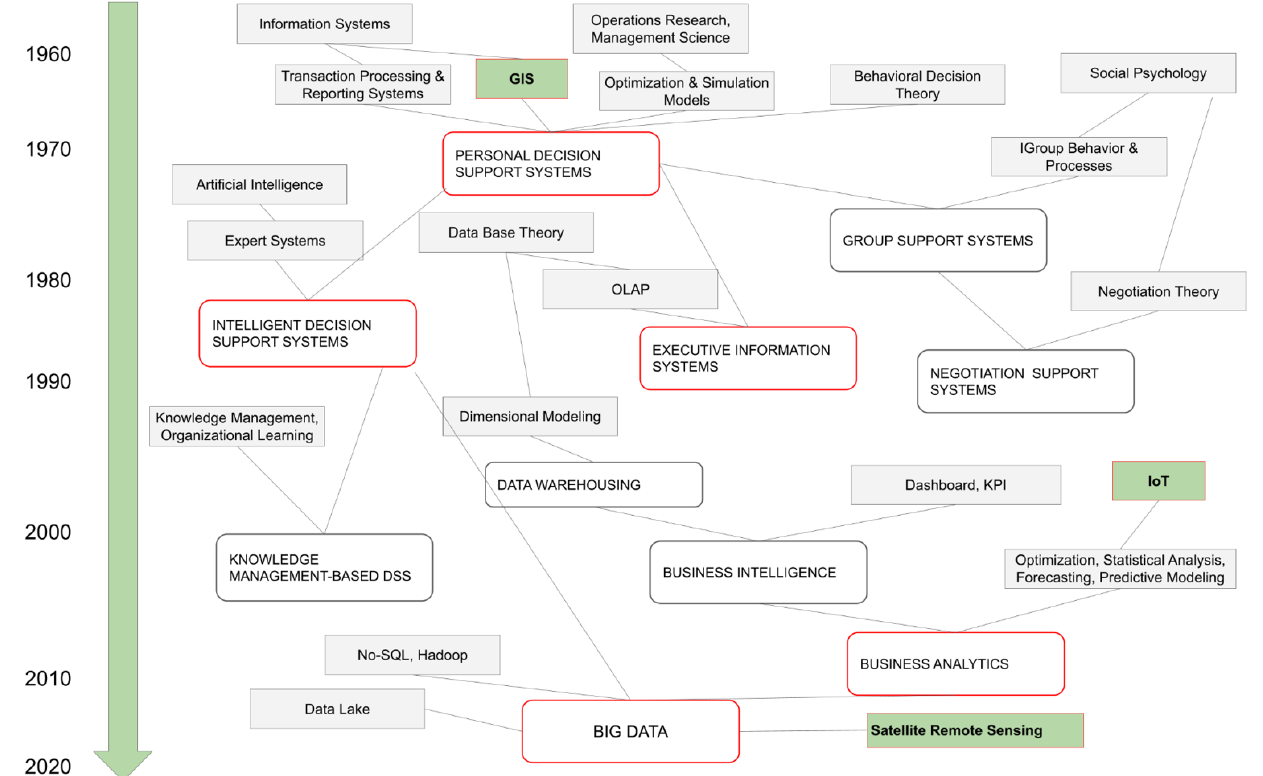
Figure 1. Evolution of DSS through partially connected subfields [21].